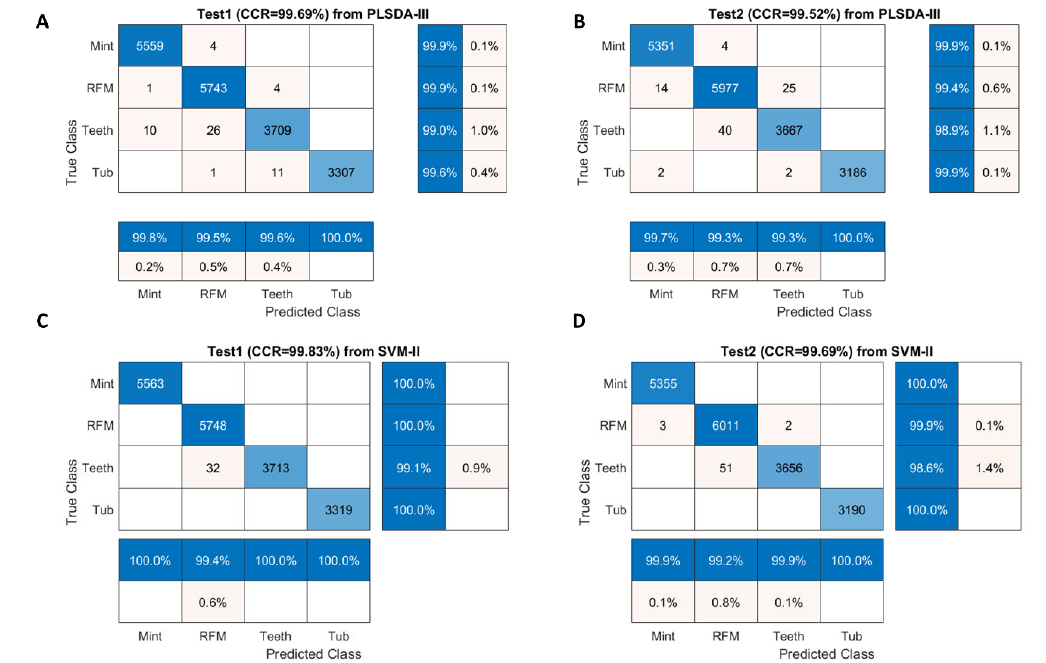
Figure 4. Confusion matrices for Test 1 image ( A ) and Test 2 image ( B ) obtained from PLSDA ‐ III model; for Test 1 image ( C ) and Test 2 image ( D ) obtained from SVM ‐ II model.